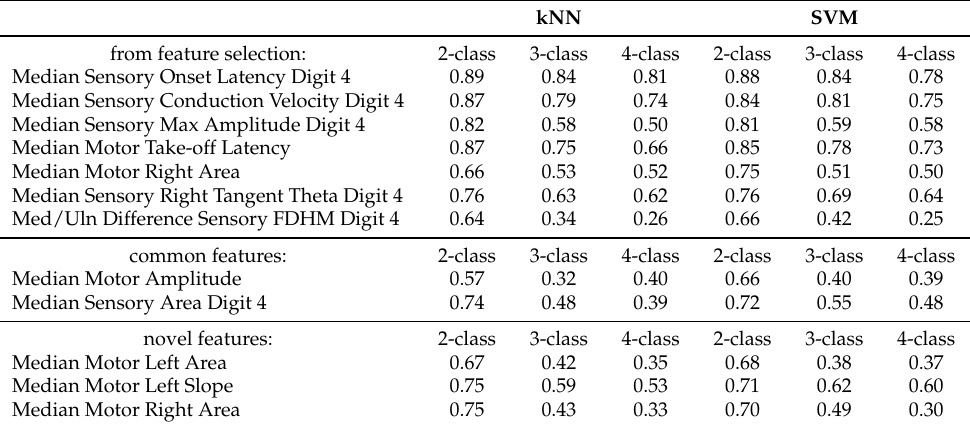
Table 5. Accuracy achieved by each feature